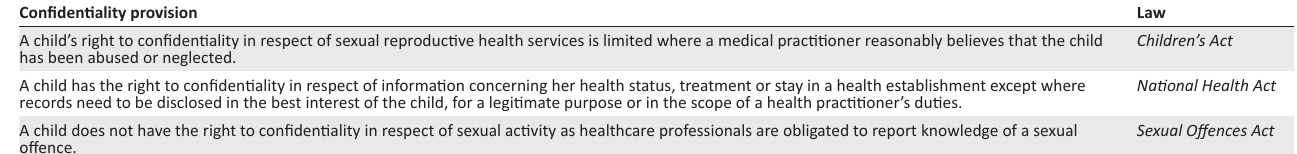
TABLE 2: Confidentiality provisions in law.